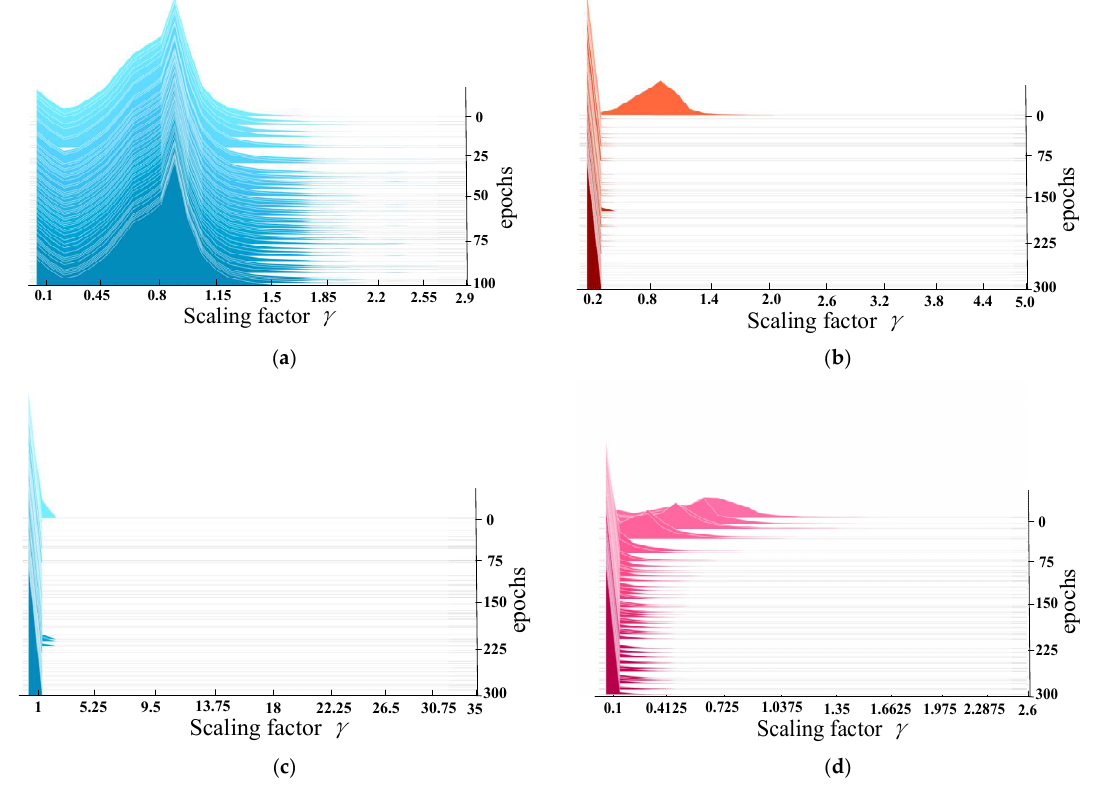
Figure 9. ( a ) Histogram of the distribution of scaling factors of the BN layer for basic training prior to sparsity training ( b – d ). Histograms of the distribution of the BN layer scaling factors for sparsity training, with sparsity factors of 0.01, 0.005, and 0.001.